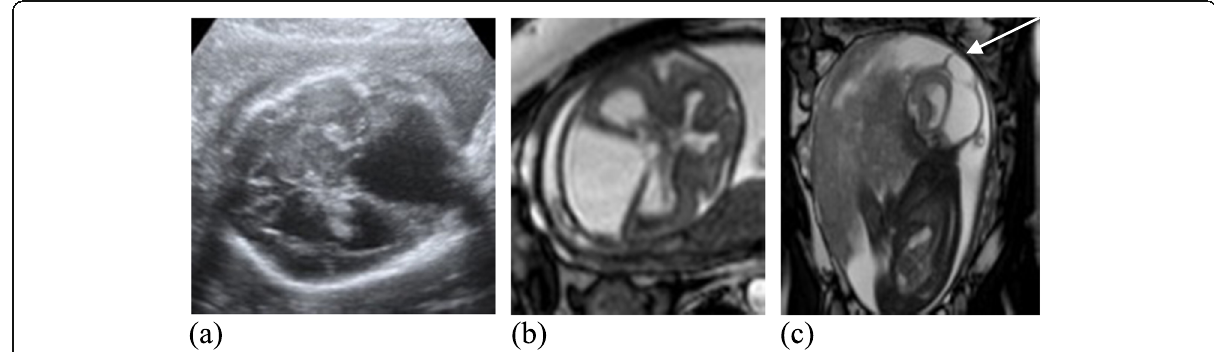
Fig. 1 Twenty-five-week fetus a US showed infratentorial arachnoid cyst. b , c Axial and sagittal MRI (B-FFE) images confirmed the diagnosis and added the presence of posterior parietal meningocele